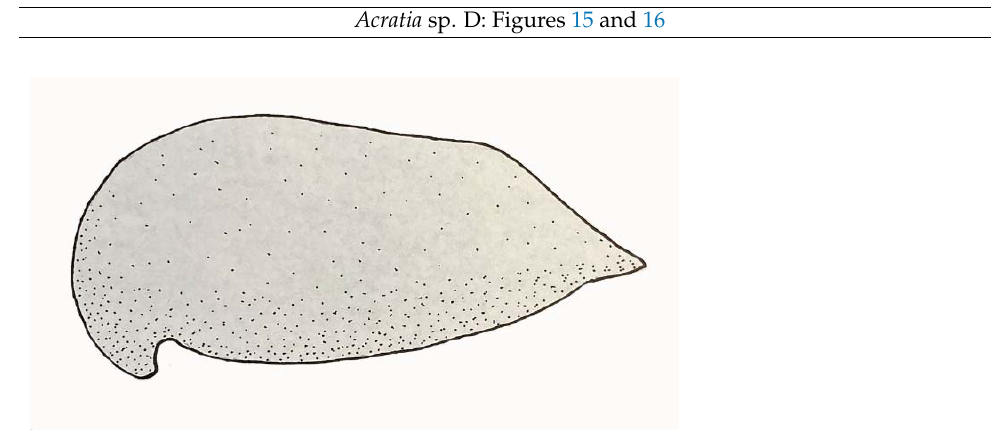
Figure 15. Acratia sp. D, left valve, lateral view. IGM 5011(11). Width of valve ~1 mm. Image credit: Mark McMenamin.